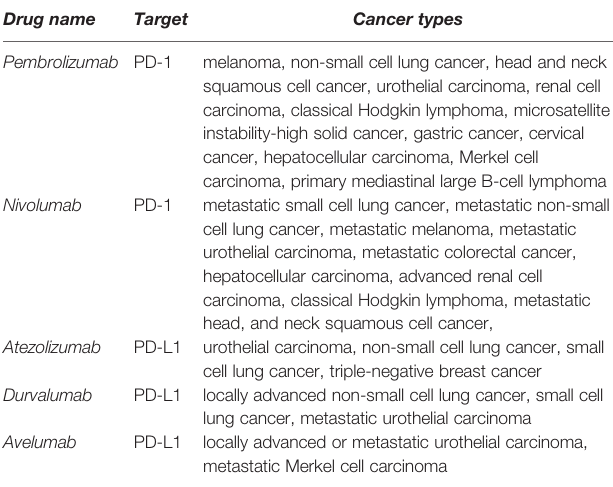
TABLE 1 | FDA-approved PD-L1/PD-1 inhibitors for cancer